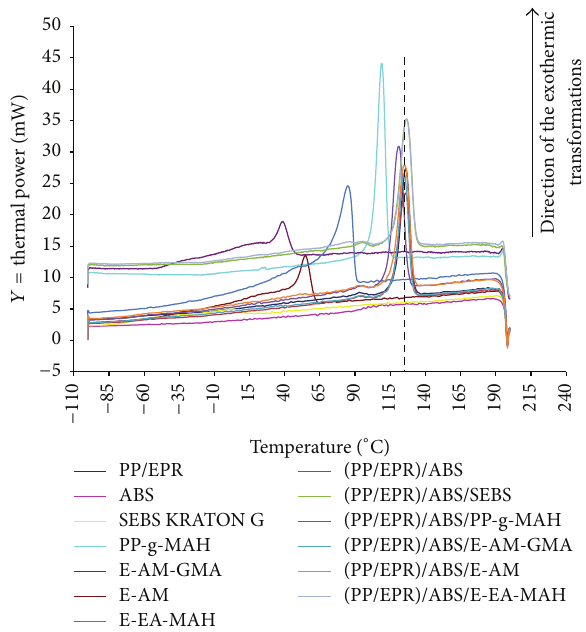
Figure 12: DSC curves in the direction of the exothermic transfor- mations of components and mixtures (PP/EPR)/ABS/compatibiliz- er (95)/5/5, for the second thermal cycle. For about 15 mg of sample. 1 graduation 𝑌 = 5